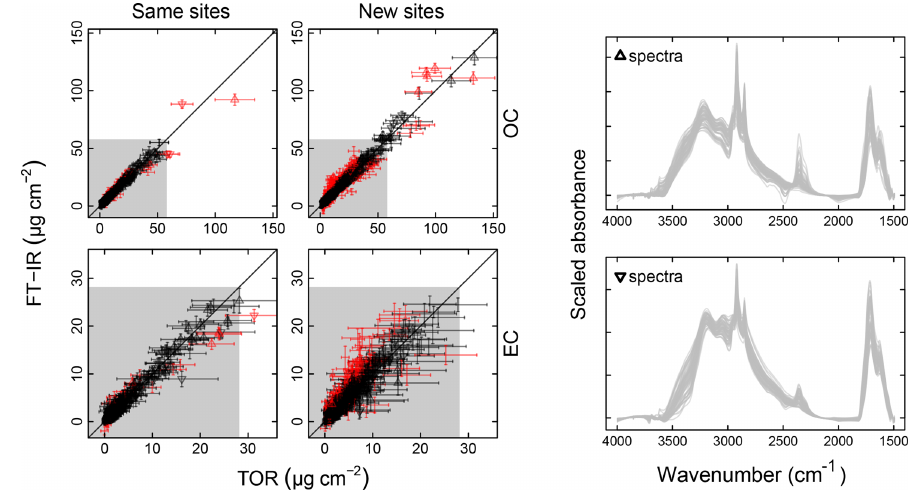
Figure 12. Point estimates and prediction intervals for the TOR-equivalent concentrations in the 2013 IMPROVE prediction set. Gray shades indicate the extent of areal mass densities in the calibration samples. Triangles represent samples associated with burning (scaled spectra shown in the right column). Red samples correspond to those for which the difference between predicted and observed concentrations exceeds the combined uncertainties at the α = 0 . 05 significance level.